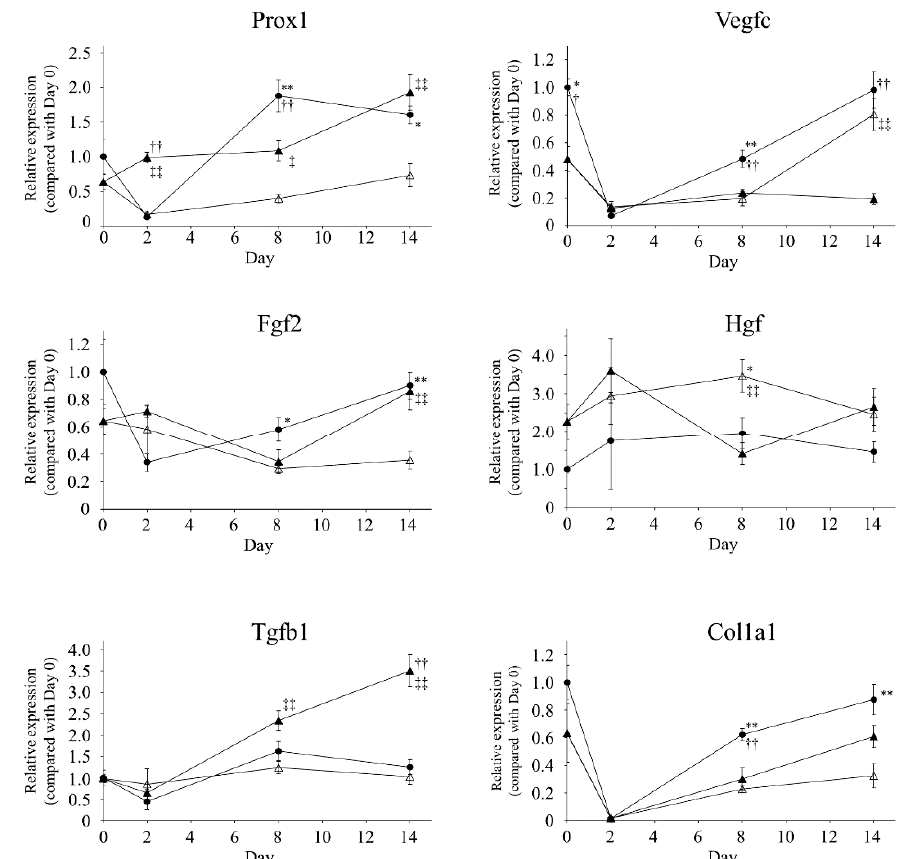
Figure 5. Gene expression analysis. Each gene expression is shown as fold change from the mean value of the X-ray/ADSC ( − / − ) group at day 0 (mean ± SE). * p < 0.05, ** p < 0.01: significantly different between X-ray/ADSC ( − / − ) and X-ray/ADSC (+/ − ). † p < 0.05, †† p < 0.01: significantly different between X-ray/ADSC ( − / − ) and X-ray/ADSC (+/+). ‡ p < 0.05, ‡‡ p < 0.01: significantly different between X-ray/ADSC (+/ − ) and X-ray/ADSC (+/+). Symbols represent each study group ( n = 4–6 mice/group): X-ray/ADSC ( − / − ) ( ● ), X-ray/ADSC (+/ − ) ( △ ), X-ray/ADSC (+/+) ( ▲ ).